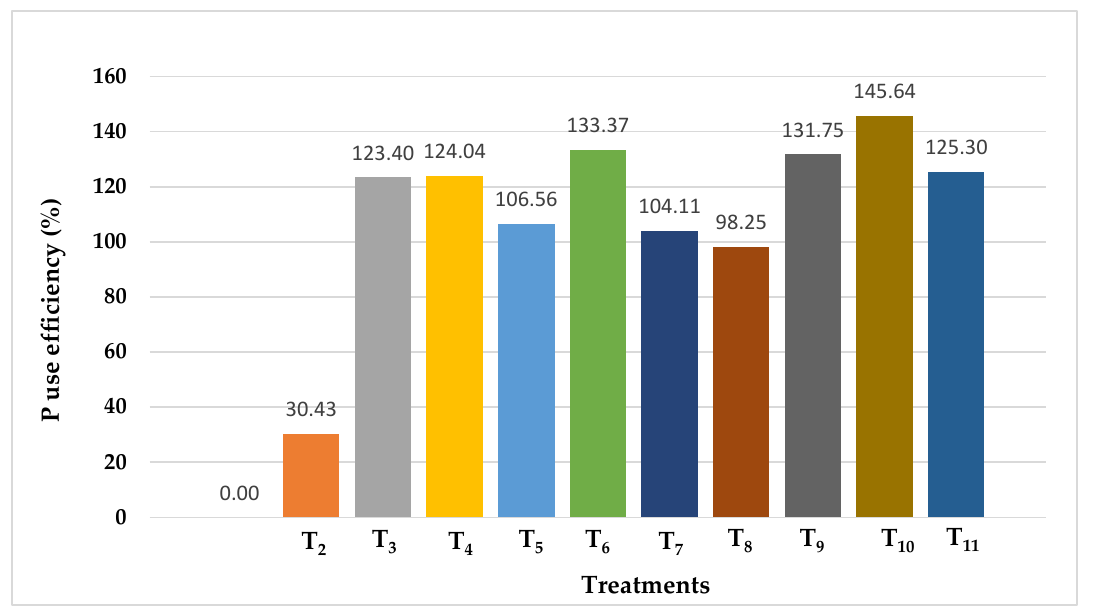
Figure 2. Effect of treatments on phosphorus use efficiency. T 1 = No treatments and fertilizer (Control), T 2 = Recommended rate of NPK (t ha −1 ), T 3 = 100% dolomitic limestone + 10 t ha −1 rice husk biochar + 100% TSP, T 4 = 100% dolomitic limestone + 10 t ha −1 rice husk biochar + 75% TSP, T 5 = 100% dolomitic limestone + 10 t ha −1 rice husk biochar + 50% TSP, T 6 = 75% dolomitic limestone + 10 t ha −1 rice husk biochar + 100% TSP, T 7 = 75% dolomitic limestone + 10 t ha −1 rice husk biochar + 75% TSP, T 8 = 75% dolomitic limestone + 10 t ha −1 rice husk biochar + 50% TSP, T 9 = 75% dolomitic limestone + 15 t ha −1 rice husk biochar + 100% TSP, T 10 = 75% dolomitic limestone + 15 t ha −1 rice husk biochar + 75% TSP, T 11 = 75% dolomitic limestone + 15 t ha −1 rice husk biochar + 50% TSP.